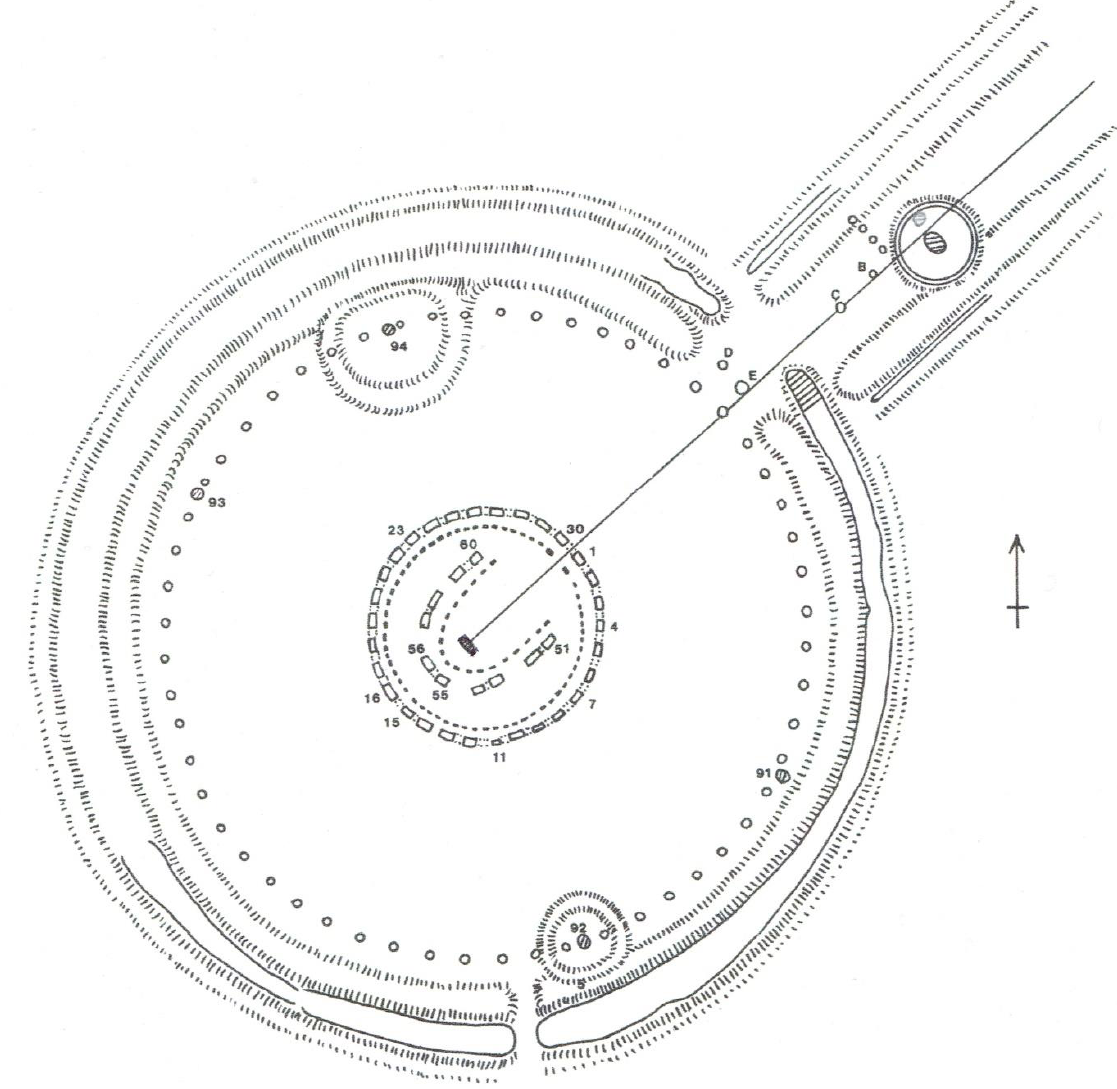
Figure 2. Plan of Stonehenge as it may have been in its final phase if construction had been fully completed. Note how the stone pair numbered 30 and 1 together with the midpoint of the recumbent Altar Stone define the axis of the monument - as does the bisector of the Avenue on the final approach to Stonehenge. Yet, the Heel Stone which is 80 metres from the centre of the monument is slightly offset from the Stonehenge axis. Also note that the Heel Stone has a ring ditch around it that cuts an earlier, therefore older, stone hole (Pitts 1981: fig. 1; Cleal et al. 1995: fig. 79) which is farther from the monument than is the Heel Stone. This older stone hole (attributed to a missing Stone 97) is sketched lightly on this plan on the inside edge of the Heel Stone circle. (Author’s drawing based on published plans including Stone (1924: plate 3), excavator Hawley (1928: plate 23), Atkinson (1956: fig. 8, facing p. 204) and Pitts (1982: